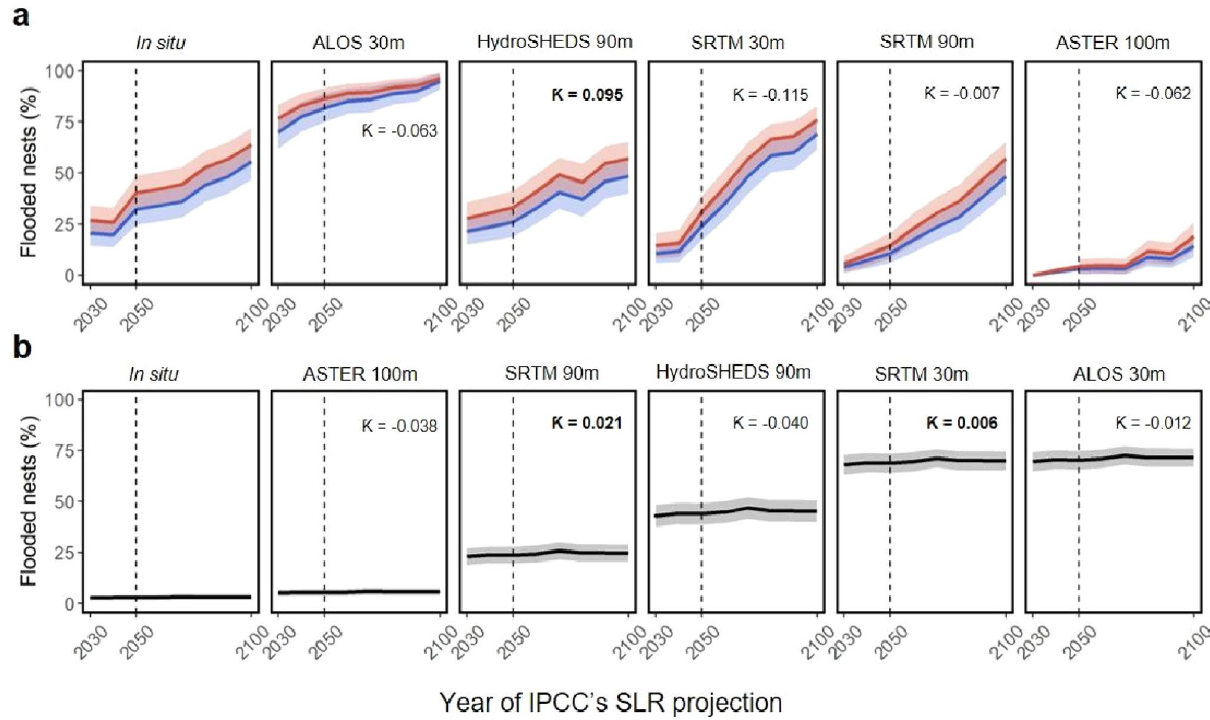
Figure 2. Summary of model predictions. Predictions of the models for different DEMs and empirical data (in situ) indicate the best fit of probability of nest flooding for ( a ) Costa Rica and ( b ) Ecuador turtle nests. IPCC sea level rise predictions are included for RCP 4.5 (blue) and RCP 8.5 (red). For Ecuador, the RCP climate change scenario did not influence the probability of nest flooding. Cohen’s kappa (κ) values for prediction (or not) of flooding for each nest compared in situ data with respective DEM datasets. Bold values correspond to a small but significant relationship between the in situ and DEM